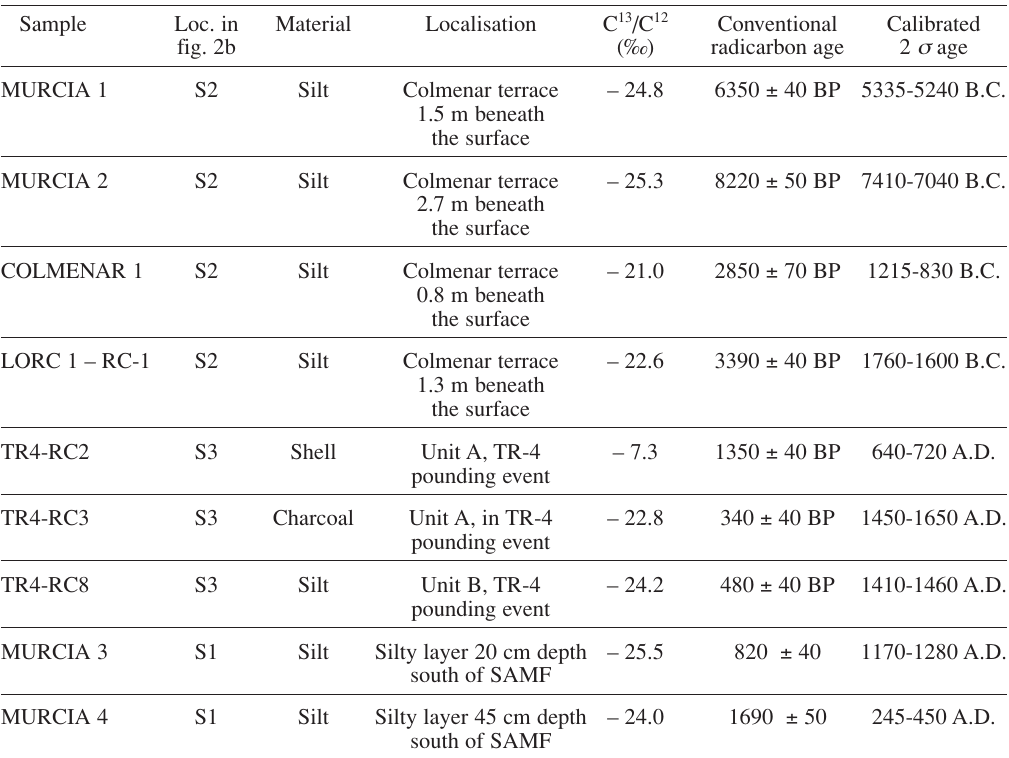
Table II. Absolute ages obtained with radiocarbon method for 9 samples collected at sites S1, S2 and S3 (see fig. 2b). Silty samples are AMS dates and Charcoal and Shell are conventional method dates. Measured C 13 /C 12 were calculated relative to the PDB-1 international standard and the radiocarbon years before present ages were normalized to – 25 ‰. Dates were done at Beta